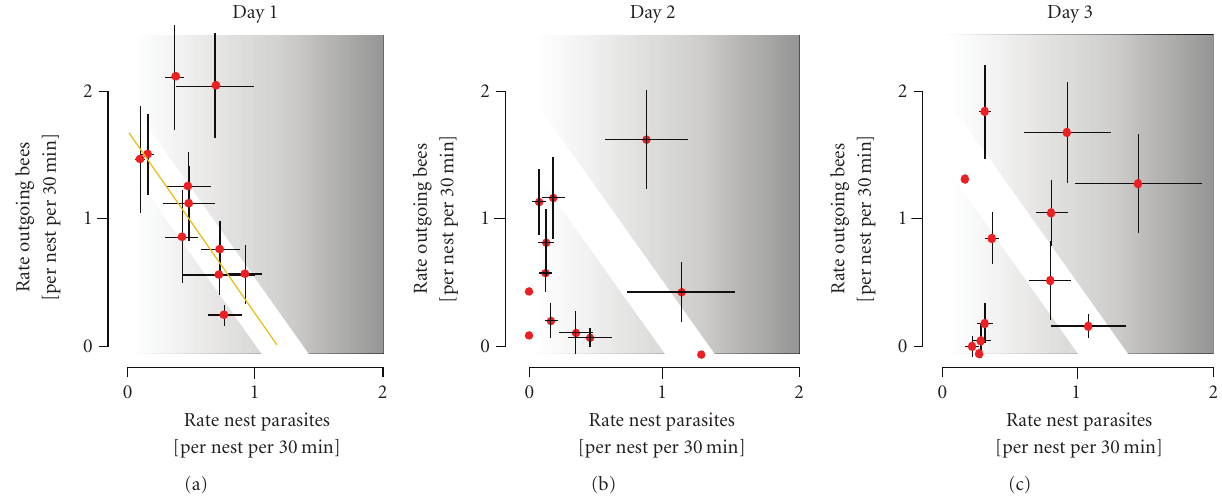
Figure 8: Correlation between the foraging rates and the impact rates of nest parasites on three successive days with di ff erent weather conditions. Values were normalized to nest and 30 minutes of observation time. On day 1, the bees obeyed the simple rule that foraging activity decreases with increasing parasite impact (regression function: F out = − 0 . 4903 ∗ I p + 1 . 6834; n = 9; r = 0 . 892; P < . 001; shown by a white stripe in the correlations graphs of all experimental days). The graphs indicate that averaging of the daily rates of bee and parasite activities is crucial, in particular due to the massive influence of weather